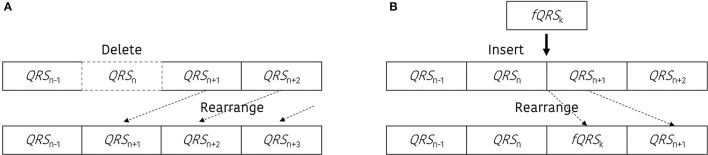
Graphical representation to update the dataset including the beat errors. (A) Procedure to generate the miss-detected QRS dataset, (B) procedure to generate the false-detected QRS dataset.